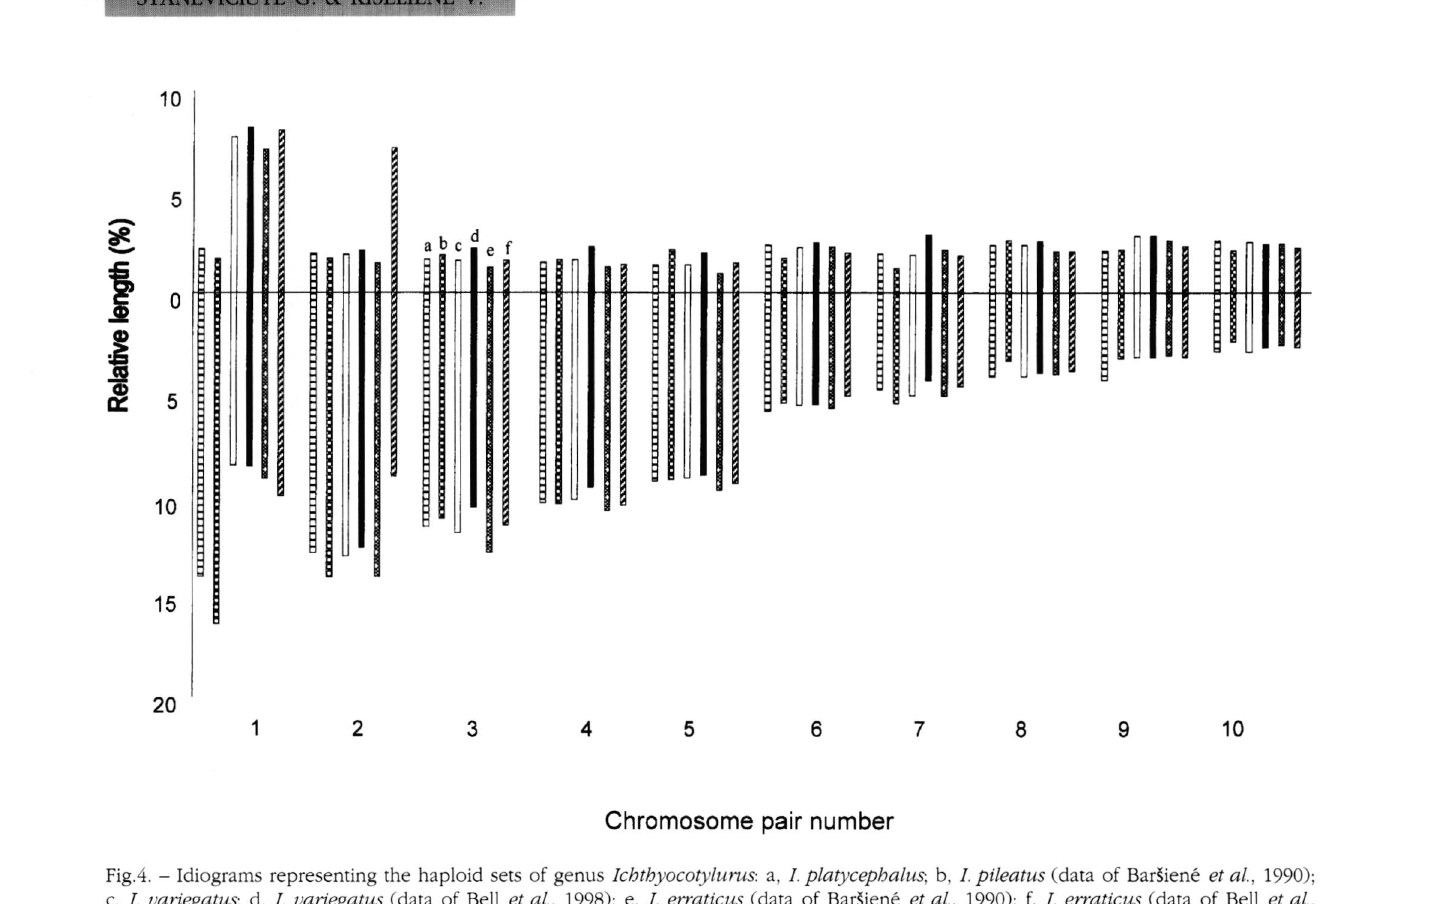
Fig.4. - Idiograms representing the haploid sets of genus Ichthyocotylurus: a, I. platycephalus; b. I. pileatus (data of BarSiené et al, 1990); c, I. variegatus; d, I. variegatus (data of Bell et al., 1998); e, I. erraticus (data of BarSiené et al, 1990); f, I. erraticus (data of Bell et al,